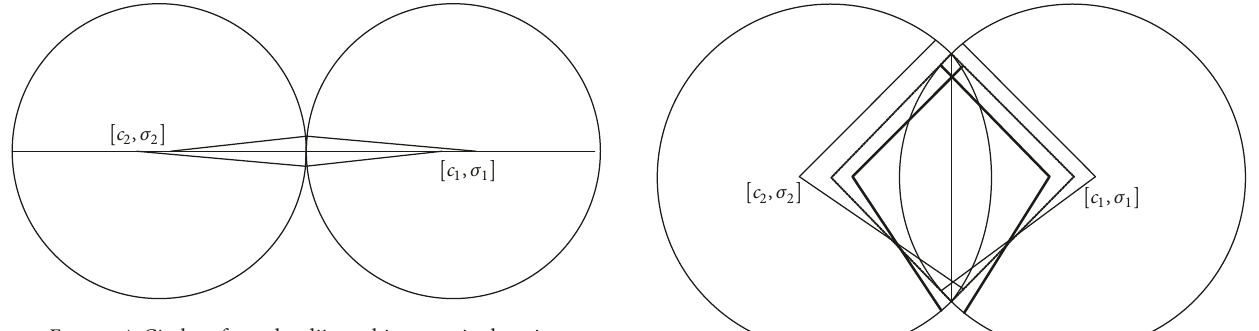
Figure 4: Circles of equal radii touching at a single point.